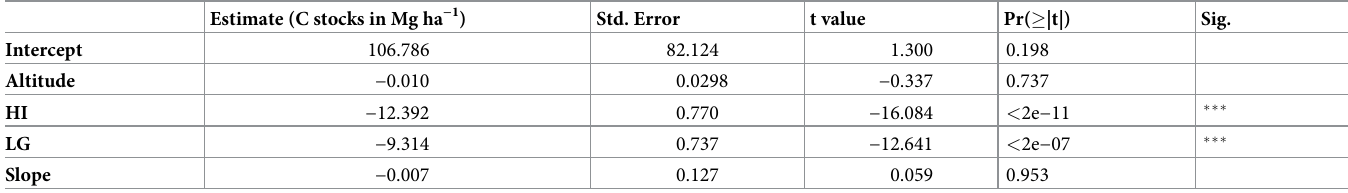
Table 5. Predictive physical environmental and anthropogenic factors for the response of TC stock distributions in Kibate Forest. Estimate (C stocks in Mg ha − 1 ) Std. Error t value Pr( � |t|) Sig. Intercept 106.786 82.124 1.300 0.198 Altitude − 0.010 0.0298 HI − 12.392 0.770 ��� LG − 9.314 0.737 − 12.641 < 2e − 07 ��� Slope − 0.007 0.127 0.059 0.953 Altitude (m a.s.l.); HI = Human impacts; LG = Livestock grazing; Slope (%); Residual standard error: 5.638 on 61 degrees of freedom; Multiple R-squared: 0.9349,